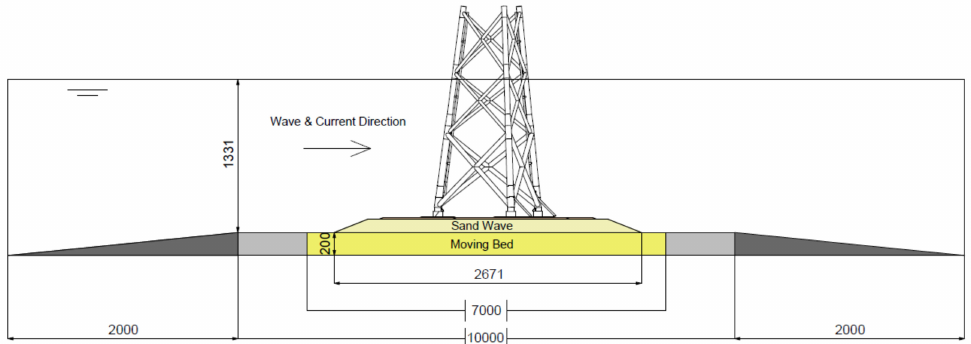
Figure 4. Longitudinal section of the concrete bathymetry